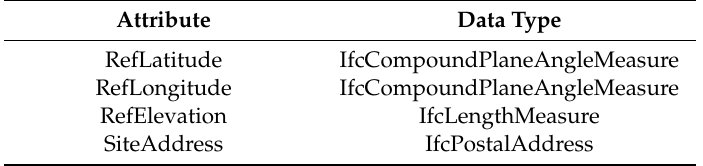
Table 4. Attributes of “IfcSite” for managing survey header information (extracted from [46]).